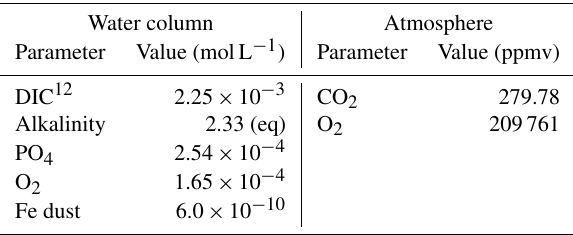
Table 1. List of initial conditions. Water